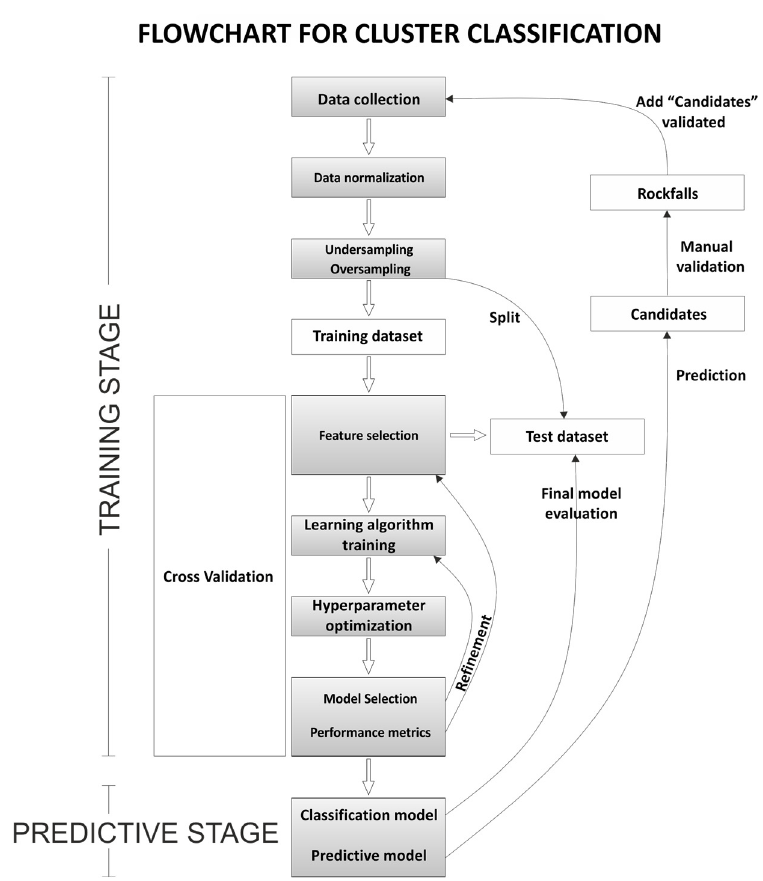
Figure 5. Flowchart of the supervised machine learning model to classifier clusters of rockfalls. Data collection corresponds to clusters of points created with PCM software. Table 3. Different resampling methods to correct the imbalance between classes.